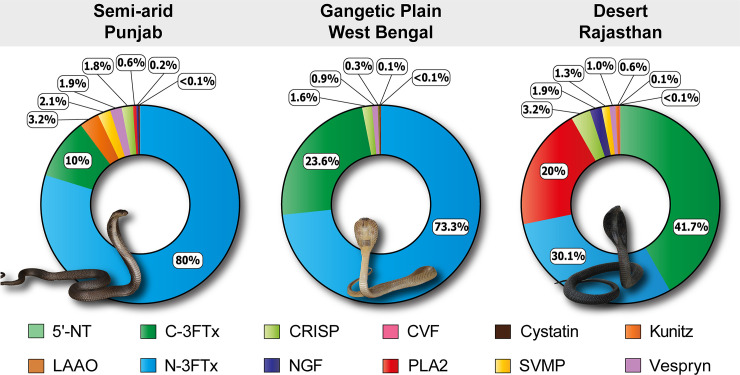
Proteomic compositions of N. naja venoms from various biogeographic regions.Doughnut charts depicting the relative abundances of various toxins comprising the venoms of N. naja are presented here. Individual toxins are colour coded, and their relative abundances are indicated in percentages.